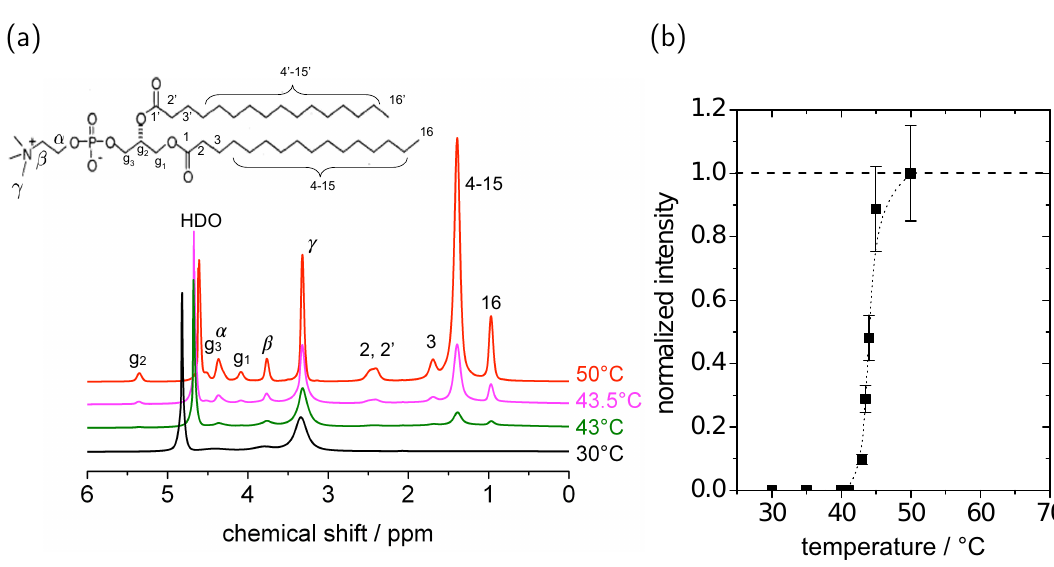
Figure 3. ( a ) 1 H spectra of dipalmitoylphosphatidylcholine (DPPC) at different temperatures and ( b ) temperature dependence of the acyl chain peak intensity, normalized such that it reaches unity at high